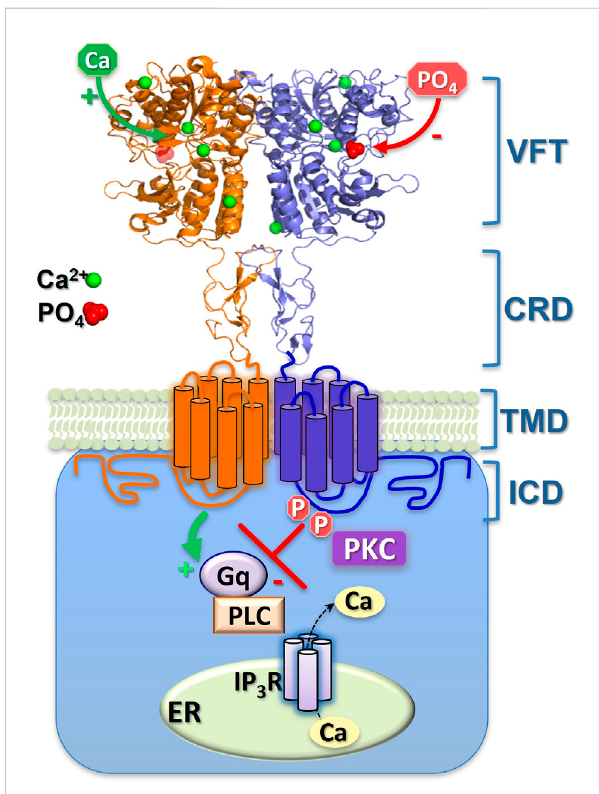
FIGURE 2 Schematic representation of CaR inhibition by extracellular phosphate ions and by intracellular, covalent phosphorylation. The binding-sites of the (activating) Ca 2+ and (inhibitory) phosphate (PO 4 ) ions shown here are approximate, though their 4:1 ratio is consistent with both the crystal models and functional Hill coef fi cients. Sustained phosphorylation (P) of ICD residues CaR S875 and CaR T888 supresses Ca 2+ i mobilisation. Episodic dephosphorylation of CaR T888 (at least) permits Ca 2+ i oscillations, while continuous dephosphorylation of these sites elicits enhanced, sustained Ca 2+ i mobilisation. The two monomers of the CaR homodimer are shown either as orange or blue. G q , G protein-q/11; PLC, phospholipase C; IP 3 R, IP 3 receptor; ER, Ca 2+ stores of the endoplasmic reticulum; PKC, protein kinase C. The CaR domains shown are the venus fl ytrap (VFT), cysteine-rich domain (CRD), transmembrane domain (TMD) and intracellular domain